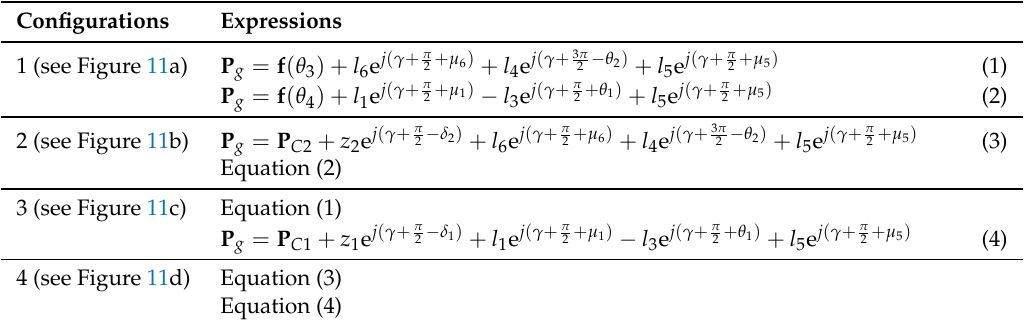
Table 1. Initial expressions that define the current position of the